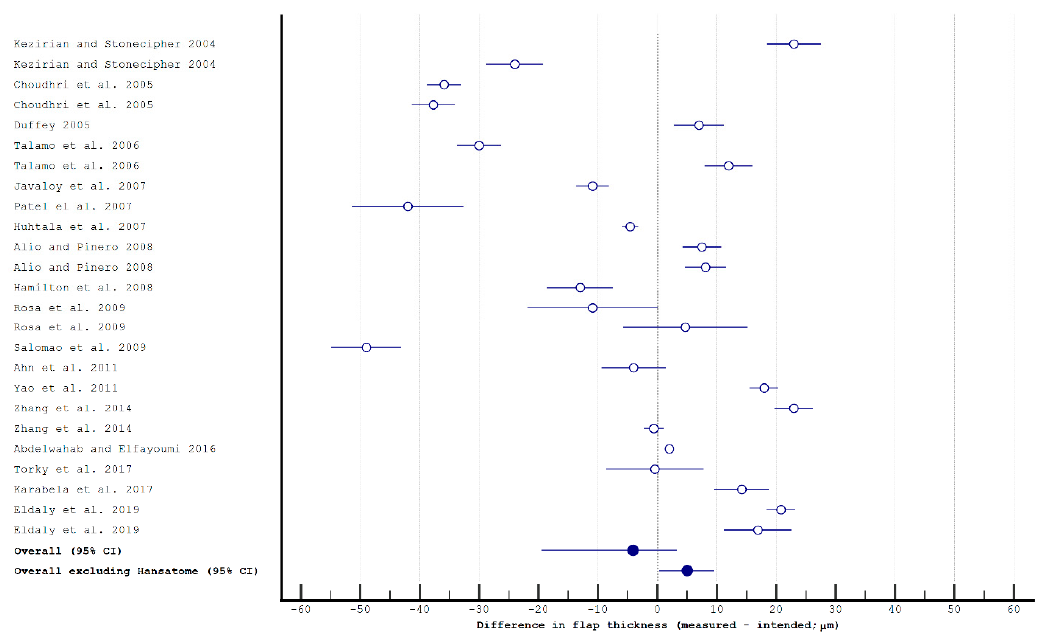
Figure 1. The flap thickness in mechanical microkeratome laser in situ keratomileusis.